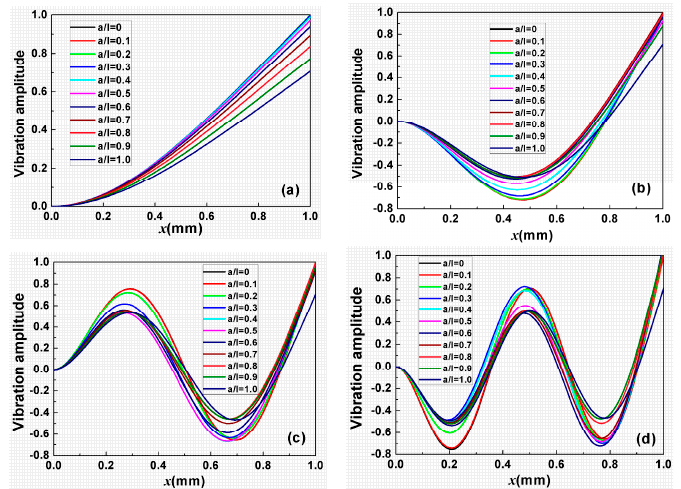
Figure 2. The mode of vibration of the cantilever with different mass load distribution ( a / l ) under: ( a ) First-order resonance mode; ( b ) Secnd-order resonance mode; ( c ) Third-order resonance mode; ( d ) Fourth-order resonance mode where ρ m A m / ρ 0 A 0 = 1.